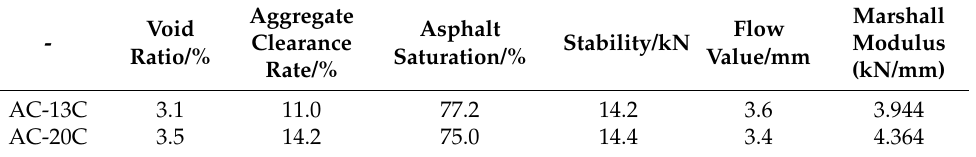
Table 4. The property of the